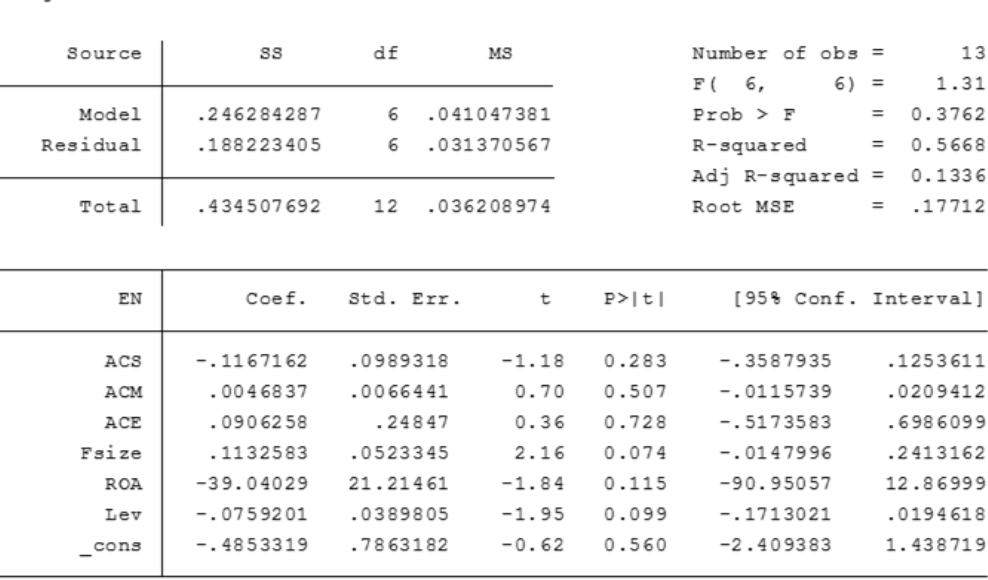
Figure 2: Results of linear regression analysis (Model